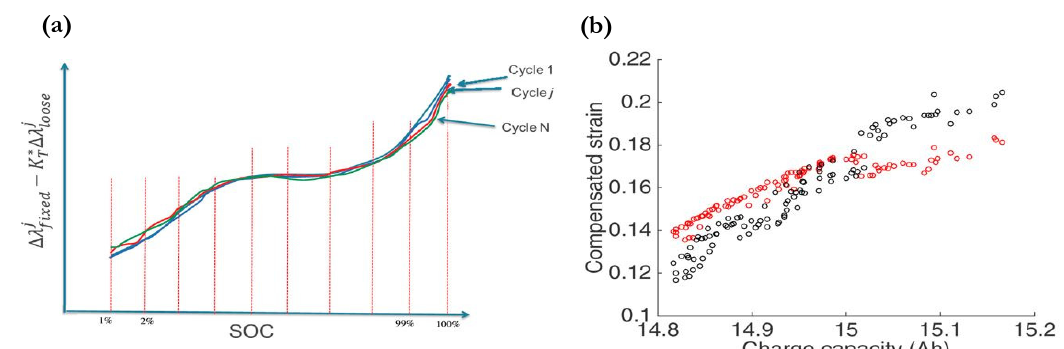
Figure 7. Experimental data of strain versus state-of-charge (SOC) and charge capacity of Li-ion pouch cells [22]: ( a ) correlation identified between temperature-compensated strain (vertical axis) and SOC; ( b ) variation of strain with charge capacity. (Reproduced with permission from Ganguli et al., Journal of Power Sources; published by Elsevier, 2017.).